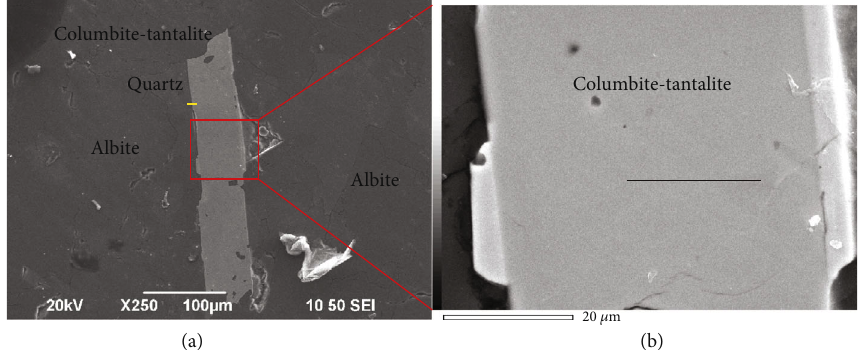
Figure 3: SEM images of the columbite-tantalite mineral. The yellow and black lines indicate the positions of the FIB section and SEM line analysis. Those results are illustrated in Figures 6 and 4,